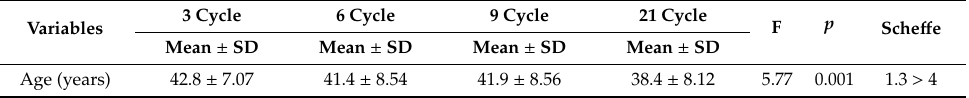
Table A1. Mean age by shift cycle with post hoc test Sche ff